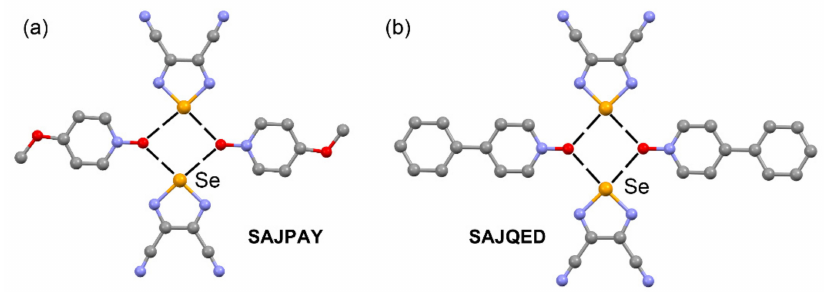
Figure 13. Ball-and-stick representation of the X-ray solid-state structures of SAJPAY ( a ), SAJQED ( b ) showing the ChBs that are represented using dashed lines. H atoms omitted for clarity.